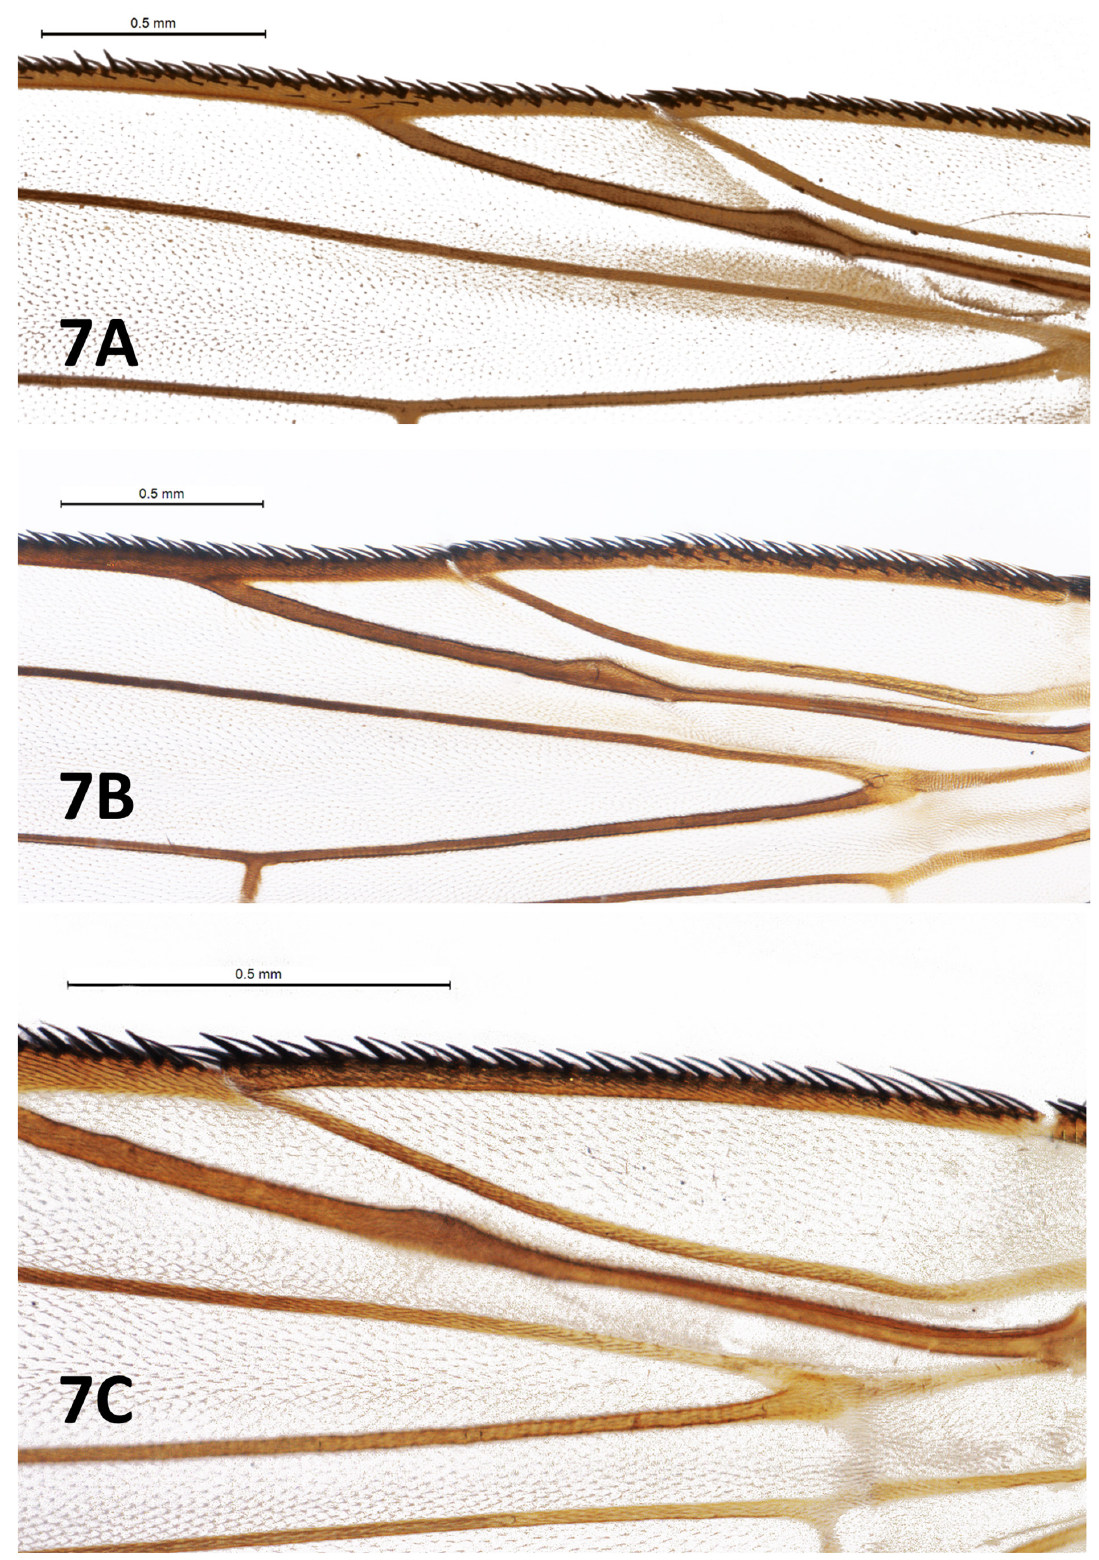
Fig. 7. ♀♀ of Hydrotaea Robineau-Desvoidy. A . H . cyrtoneurina (Zetterstedt, 1845), detail of wing showing CS1‒3, ventral view. B . H . dentipes (Fabricius, 1805), detail of wing showing CS1‒3, ventral view. C . H . meteorica (Linnaeus, 1758), detail of wing showing CS1‒2, ventral